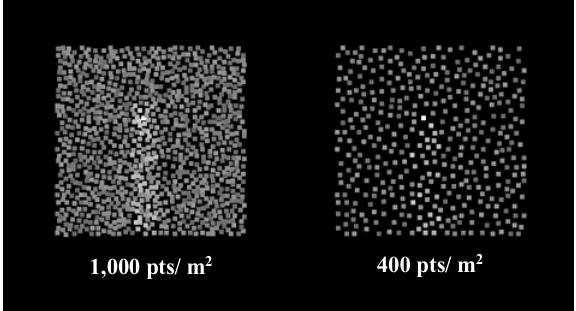
Figure 4. Difference in appearance of white line due to point